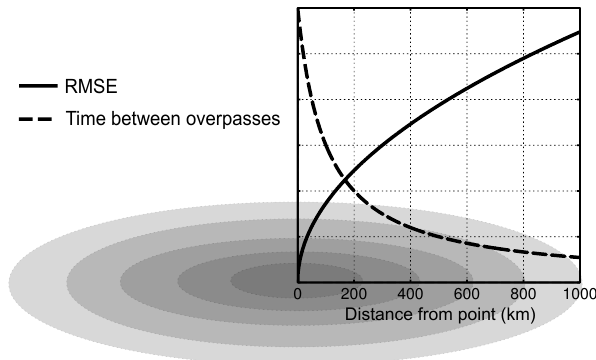
Figure 1. Conceptual illustration of trade-off between sampling fre- quency and RMSE with increasing distance (grey circles) from a lo- cation. The time between subsequent satellite overpasses decreases with distance, but the agreement between these overpasses and the conditions at the location decreases as